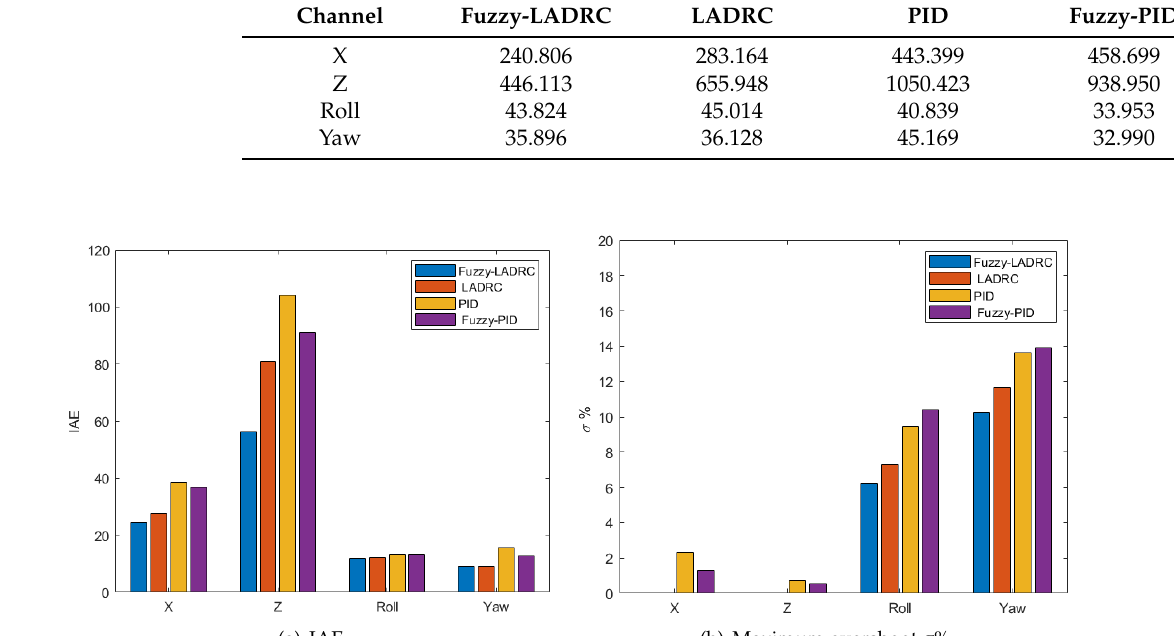
Figure 8. Comparison of IAE and σ % of four controllers in tracking step signal